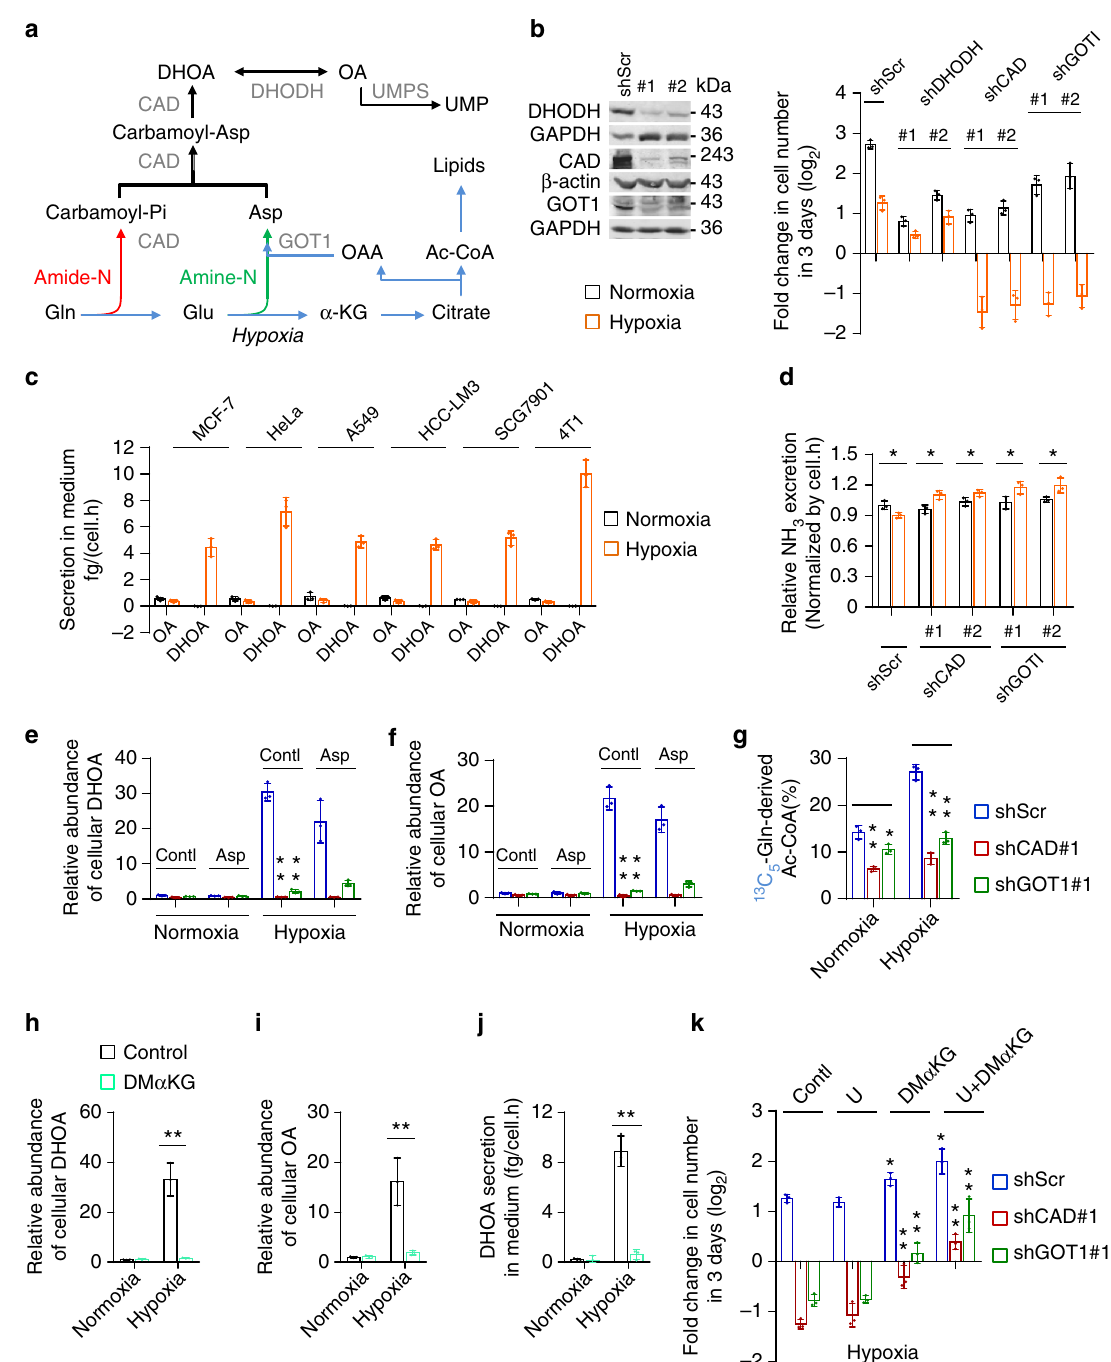
Fig. 5 Association of glutamine-carbon metabolism with its nitrogen assimilation under hypoxia. a A schematic to show the metabolism of glutamine carbon and nitrogen in the pyrimidine biosynthesis. b Proliferation of HeLa cells with or without knockdown of DHODH, CAD, and GOT1 cultured under hypoxia and normoxia for 3 days. Values are the means ± SEM of triplicate experiments. Western blot to validate the knockdown of DHODH, CAD, and GOT1. c Excretion of dihydroorotate and orotate to medium from cells cultured under hypoxia and normoxia for 8 h. d Relative ammonia excretion from HeLa/shScramble, HeLa/shCAD, and HeLa/shGOT1 cells cultured under hypoxia and normoxia for 8 h. Values are the means ± SEM of triplicate experiments. e , f Relative cellular dihydroorotate and orotate in HeLa/shScramble, HeLa/shCAD, and HeLa/shGOT1 cells cultured under hypoxia and normoxia for 8 h in the presence or absence of 10 mM aspartate. g Mass isotopomer analysis of acetyl-CoA in HeLa/shScramble, HeLa/shCAD, and HeLa/ shGOT1 cells cultured with the medium containing 1 mM of 13 C 5 -glutamine under hypoxia and normoxia for 8 h. h , i The relative abundance of cellular dihydroorotate and orotate in HeLa cells cultured under hypoxia and normoxia for 8 h in the presence or absence of 2 mM dimethyl α -ketoglutarate (DM α KG). j Excretion of dihydroorotate to medium from HeLa cells cultured under hypoxia and normoxia for 8 h in the presence or absence of 2 mM DM α KG. k Proliferation of HeLa/shScramble, HeLa/shCAD, and HeLa/shGOT1 cells cultured under hypoxia for 3 days in the presence or absence of 100 μ M uridine and/or 2 mM DM α KG. Values are the means ± SEM of triplicate experiments. All cultures were supplied with 10% dialyzed serum. Values are the means ± SEM of three independent experiments, if not speci fi ed. * p < 0.05; ** p < 0.01 (Student ’ s t